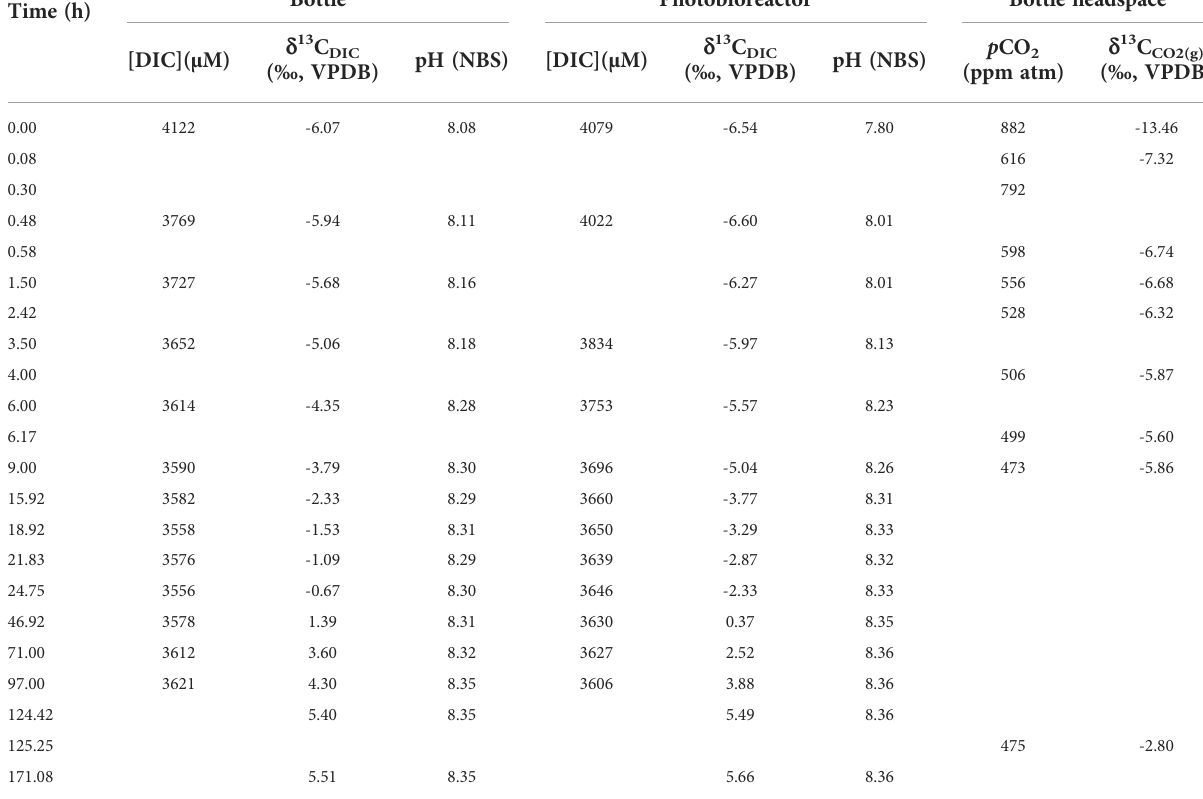
TABLE 2 DIC and CO 2 (g) in headspace measurements during small system bubbling. Time